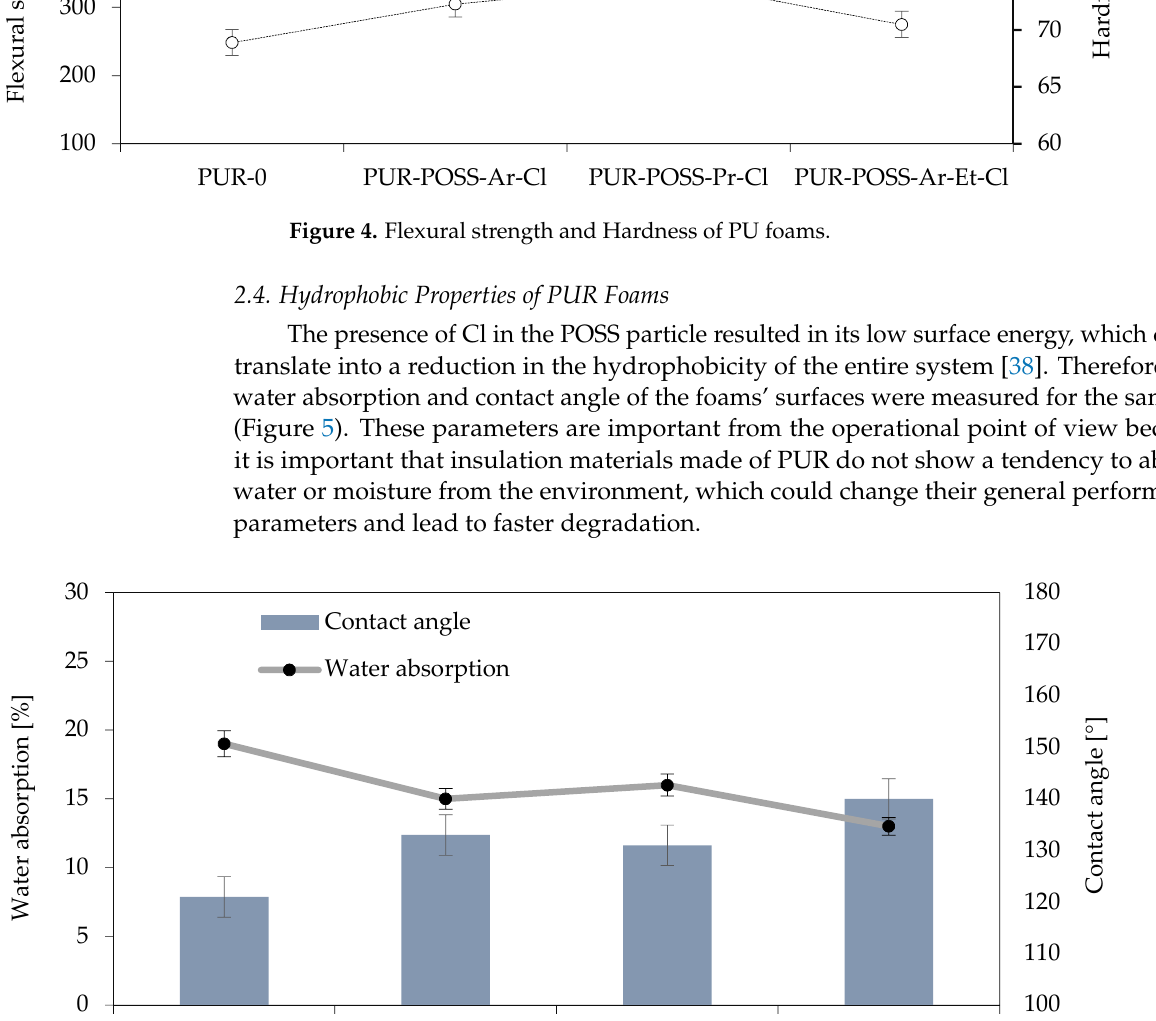
Figure 5. Effect of contact angle on water absorption of RPUFs modified with POSS-Cl.